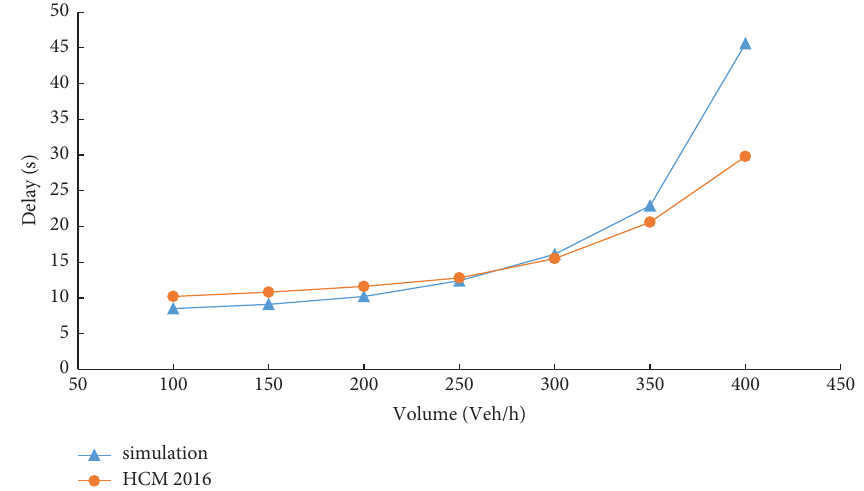
Figure 6: Te efect of volume variations on delay for single left-turn